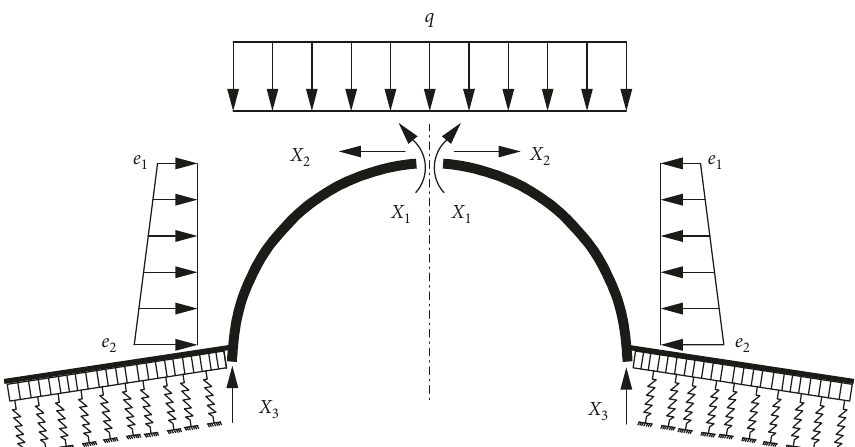
Figure 4: Mechanical model of the steel rib with the support of the feet-lock